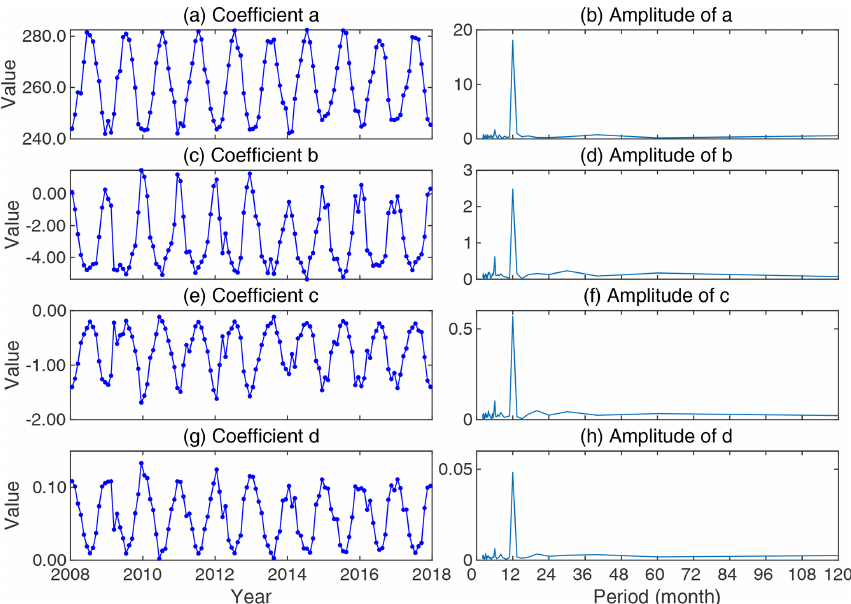
Figure 3. Periodicity reflected in the 10-year time series of each coefficient in the three-order polynomial function at 60 ◦ N, 120 ◦ E.